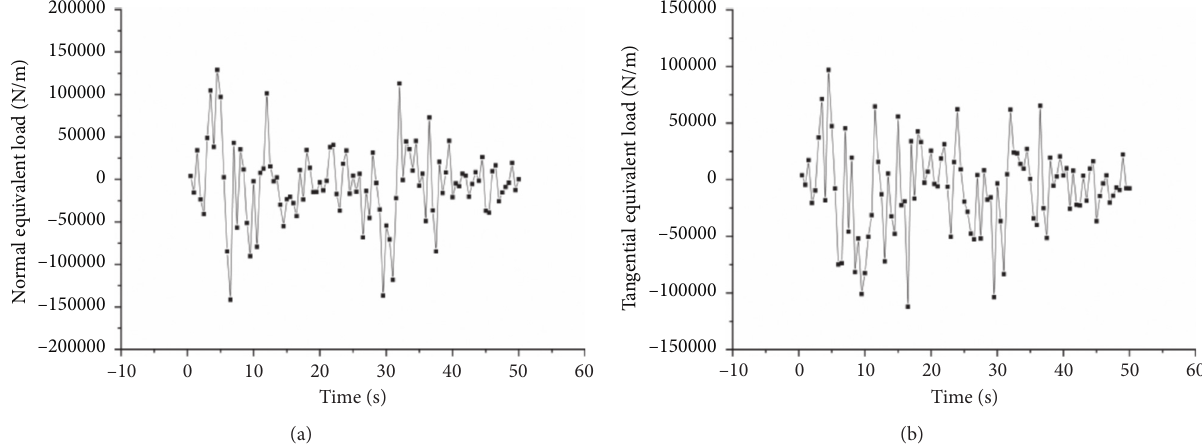
Figure 15: Boundary equivalent loads of the Taft wave. (a) Normal equivalent load F ( t ) -time F BT